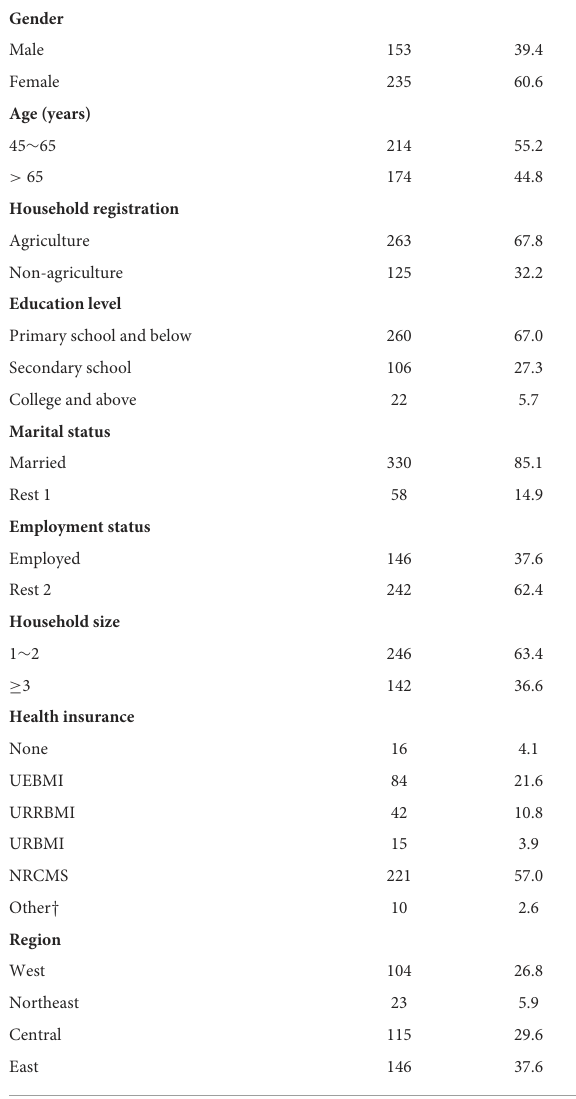
TABLE 1 Sociodemographic characteristics of cancer patients in China,